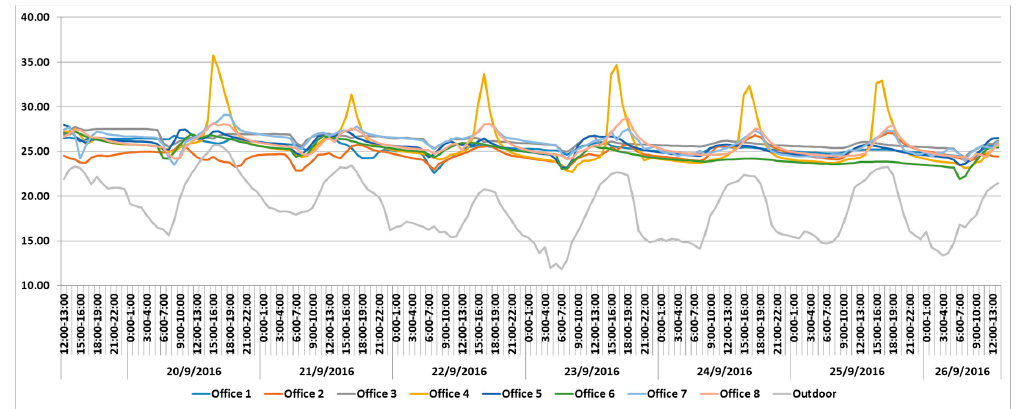
Figure 7. Temperature levels of the external and all the indoor environment of Building C during summer.